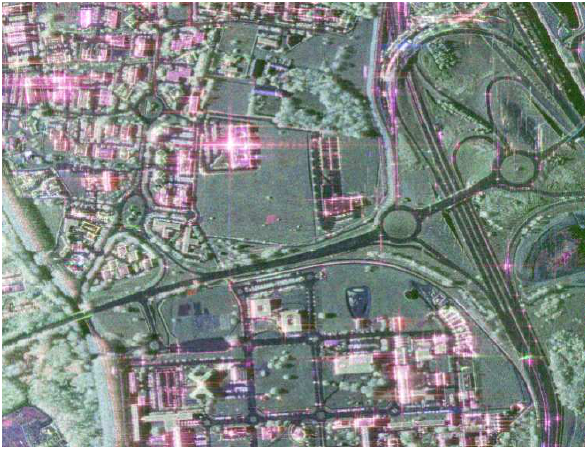
Figure 1. Studied site (Toulouse, France), represented in RGB Pauli composition